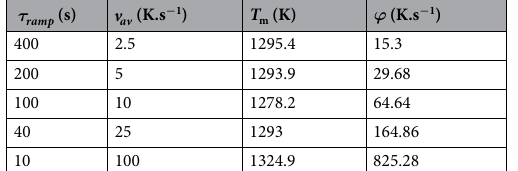
Table 2. Parameters ( T